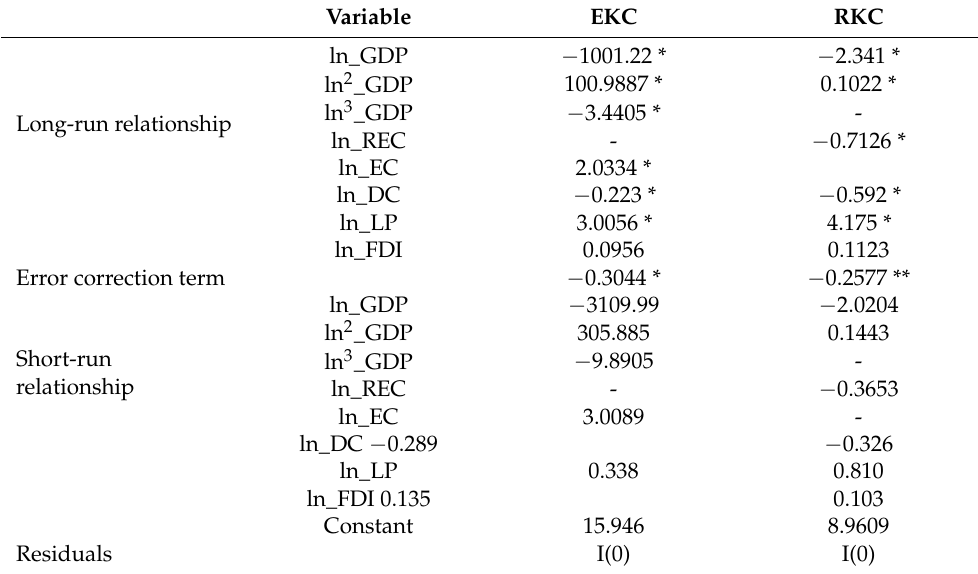
Table 7. Pool mean groups regressions in extended EKC and RKC for the V4 and Baltic countries 1 .